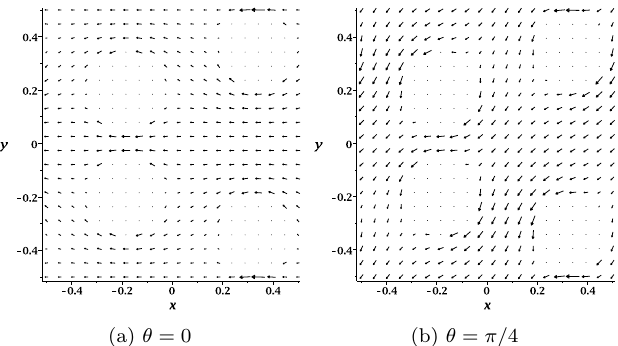
Figure 7. The flux distribution inside Q (0 , 0) for λ k = 0 . 01, γ k = 100, β k = − 0 . 01, θ = 0; π/ 4.